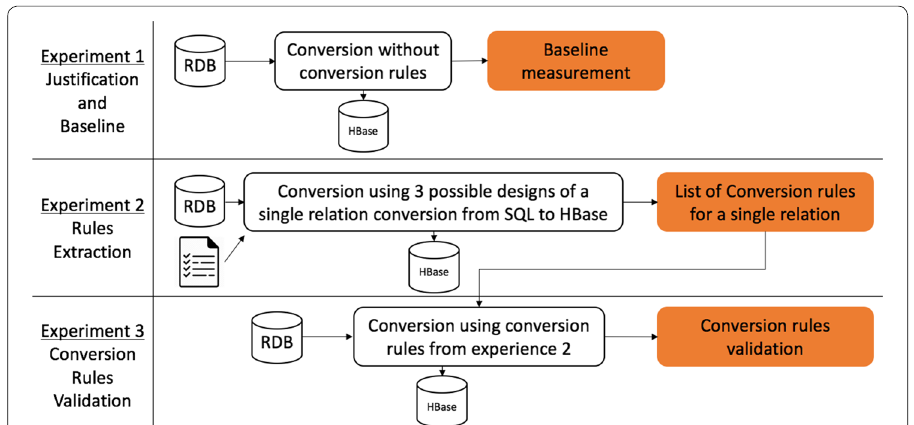
Fig. 1 The scope of this paper versus the overall research